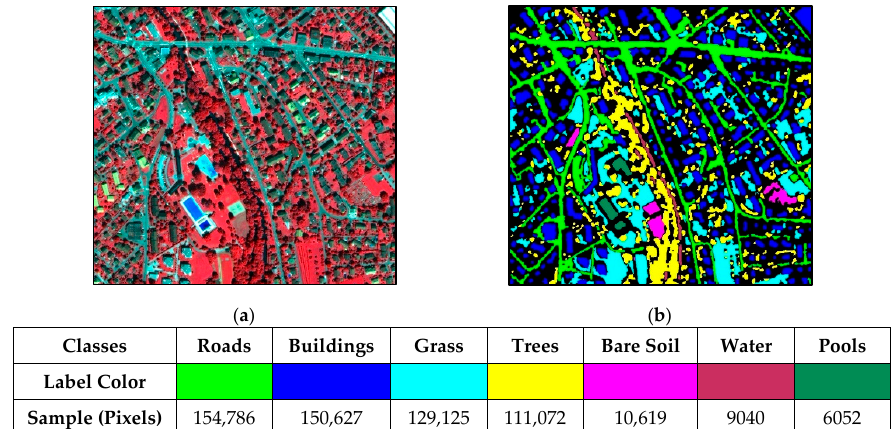
Figure 2. Zh2: ( a ) color-infrared composite (R: band 4; G: band 3; B: band 2) of the QuickBird imagery and ( b ) its reference map. Table 1. Detailed sample information used in the experiment (pixels).